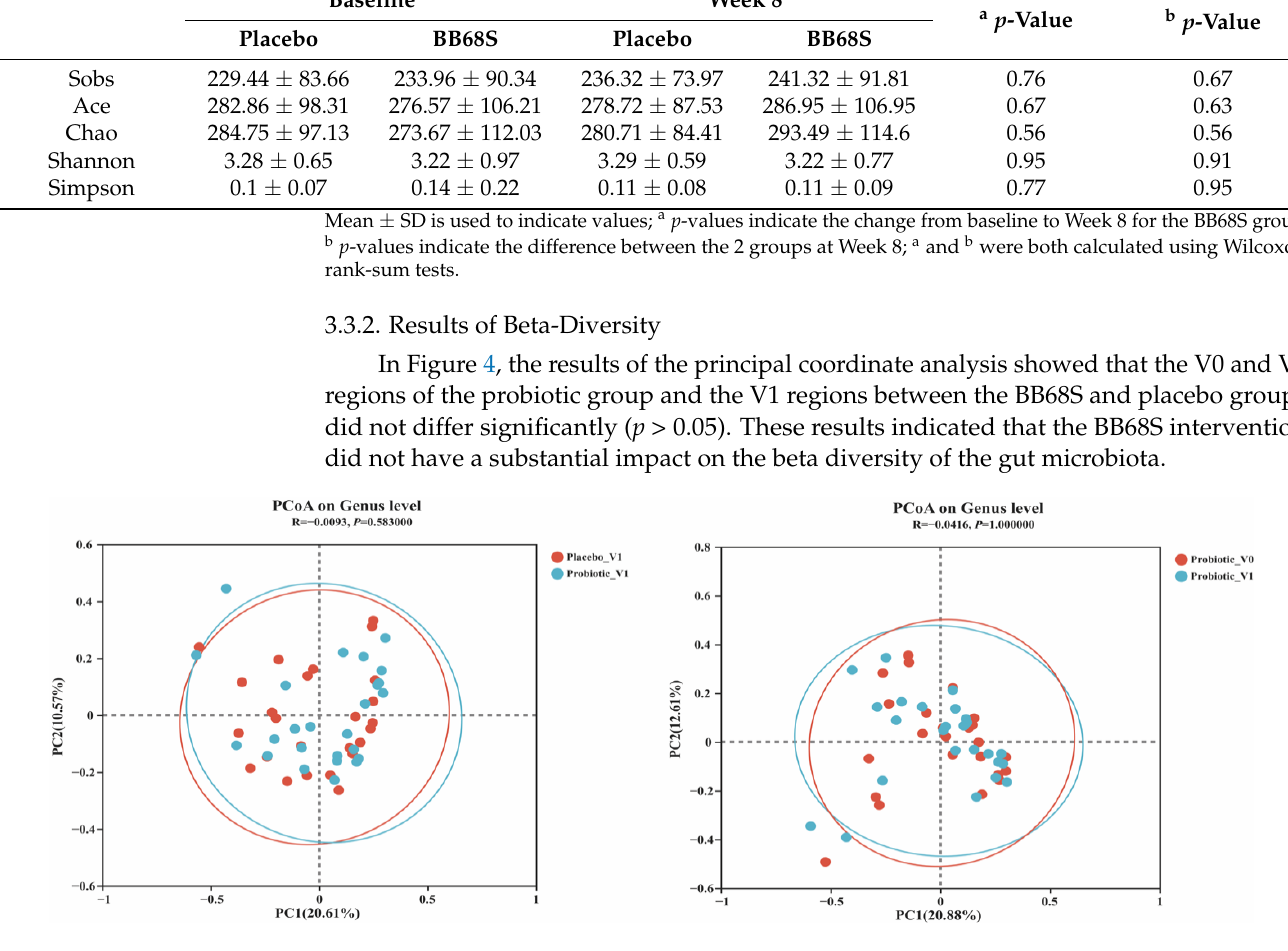
Figure 4. Principal coordinate analysis (PCoA) of the gut microbiota at the operational taxonomic unit (OTU) level. ( A ) Differences in V4 between the Placebo and Probiotic groups. ( B ) Differences between V0 and V1 in the Probiotic group. Placebo_V1: samples at V1 in the placebo group, Probiotic_V1: samples at V1 in the probiotic group, Probiotic_V0: samples at V0 in the probiotic group